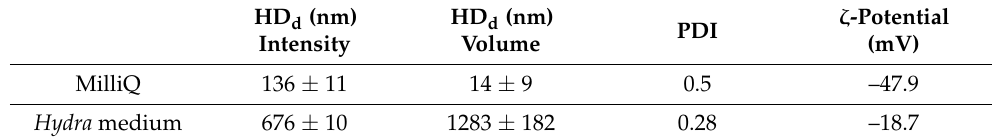
Table 1. Average hydrodynamic diameter (HD d , reported in intensity and volume), polydispersity index (PDI), and surface charge ( ζ -potential) of AgNPcitLcys as measured by DLS in MilliQ water and Hydra medium at 50 mg/L and 25 ◦ C. Data are shown as mean ± standard deviation.